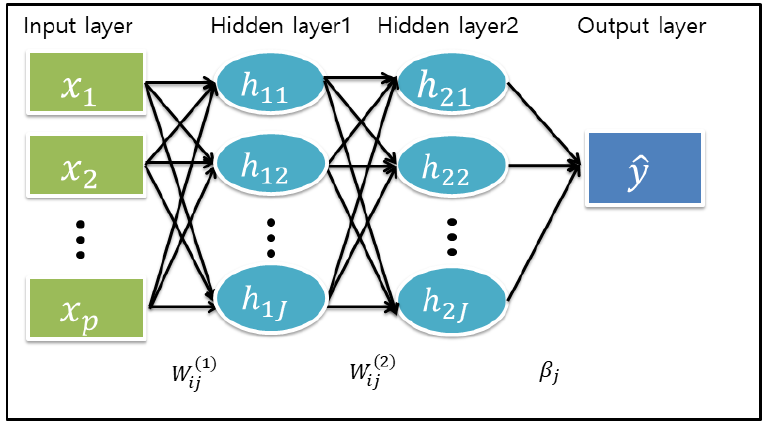
Figure 1. A feed-forward deep learning model with two-hidden layers where bias terms are omitted for brevity but are written in the main